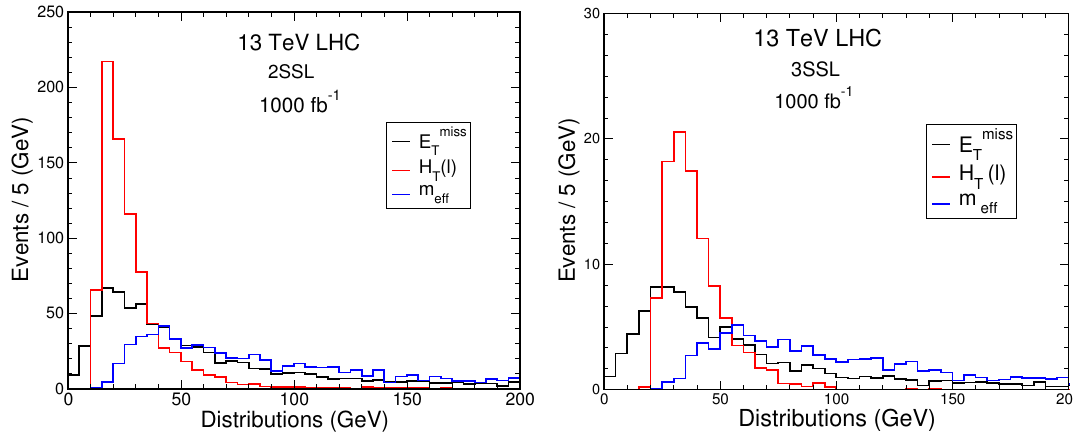
Figure 7 . The left panel shows the distributions of the missing energy ( E miss ), sum of the lepton T transverse momentum ( H T ( l ) = P p T ( l i )), and e(cid:11)ective mass ( m e(cid:11) = E T + H T ( l ) + H T ( j )) for i signal events in the 2SSL channel at the 13 TeV LHC. The right panel depicts the same in the 3SSL channel. Here leptons are l = e; (cid:22) . In both the panels, the events are weighted at 1000 fb (cid:0) 1 .